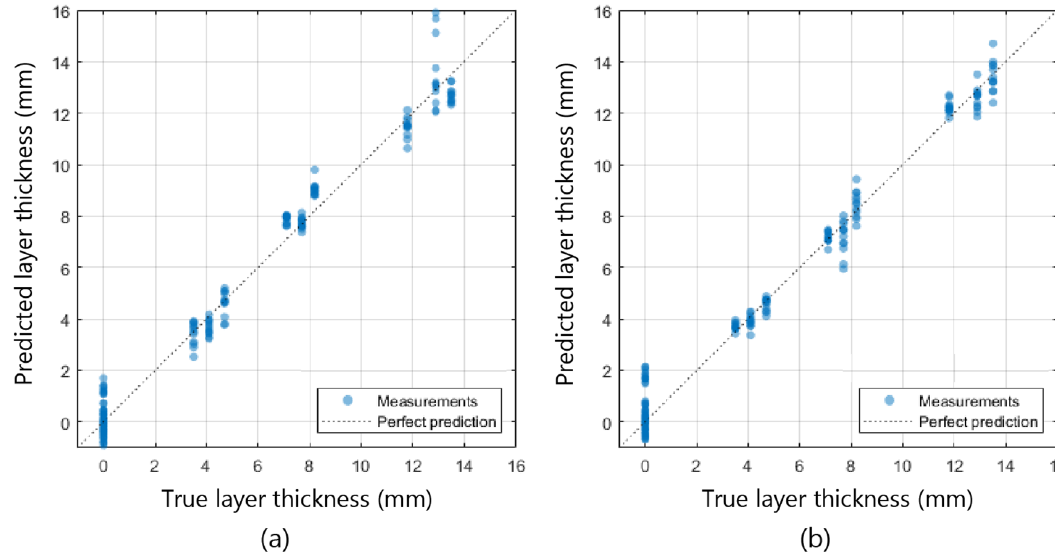
Figure 6. Predicted top layer thickness compared to the true top layer thickness, for a fiber distance of 2 mm ( a ) and 6 mm ( b ).